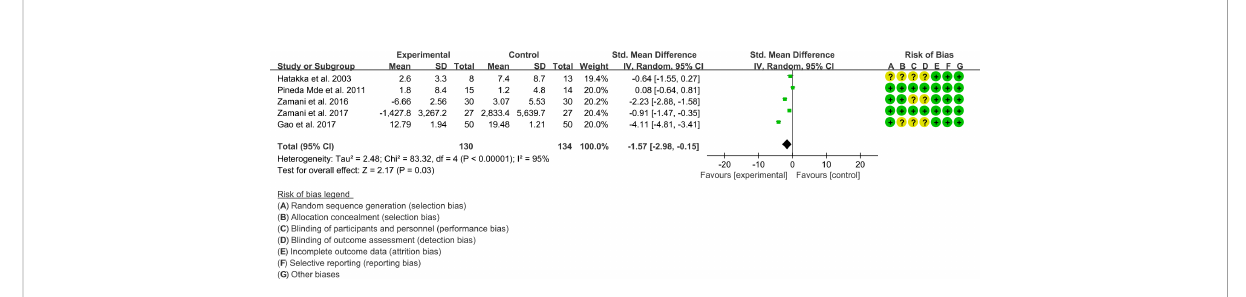
FIGURE 8 The results of CRP (CI, con fi dence interval; SD, standard deviation).